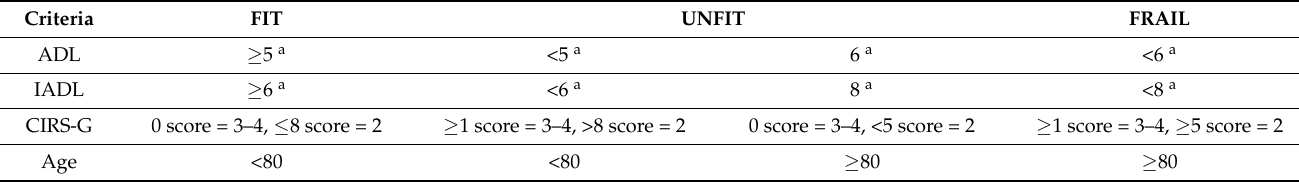
Table 1. FIL criteria for sGA